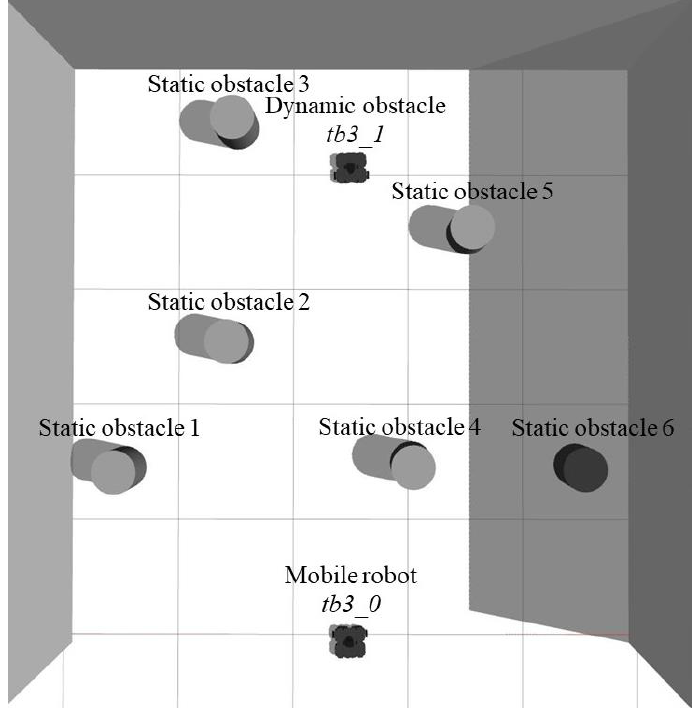
Figure 5. Simulated environment scenario 1 with labels.